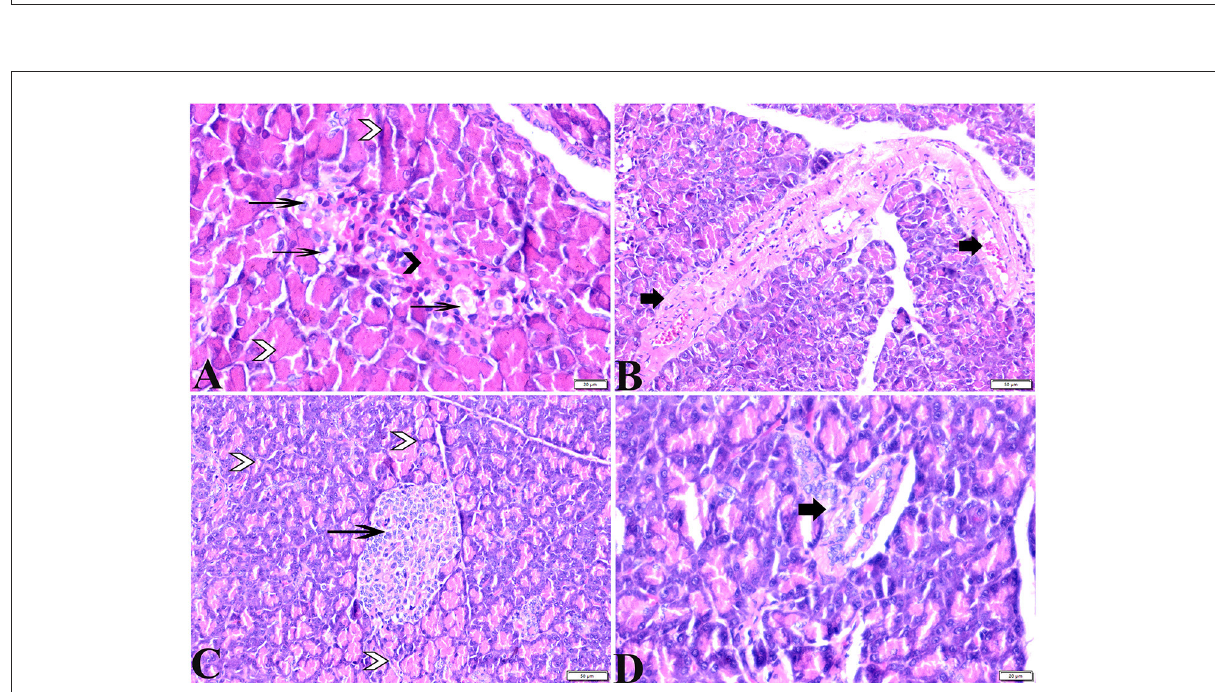
FIGURE2 Photomicrographs of pancreatic sections from (A,B) of the diabetic STZ group showing (A) islets of Langerhans that experienced depletion and necrobiotic changes in its constituent cells, vacuolated degeneration in most of the cells (thin arrows), and capillary hemorrhage (black arrowheads). The exocrine acinar cells exhibit degeneration and dissociation (white arrowheads). (B) severely dilated and congested blood vessels with thick vascular walls (arrows). (C,D) diabetic STZ + MT-treated group showing: (C) well-defined islets of Langerhans with proliferated cell populations (arrow) in between normal pyramidal acidophilic pancreatic acini (white arrowheads). (D) a normal vascular structure (thick arrow). H&E stained. The bar size is indicated under each